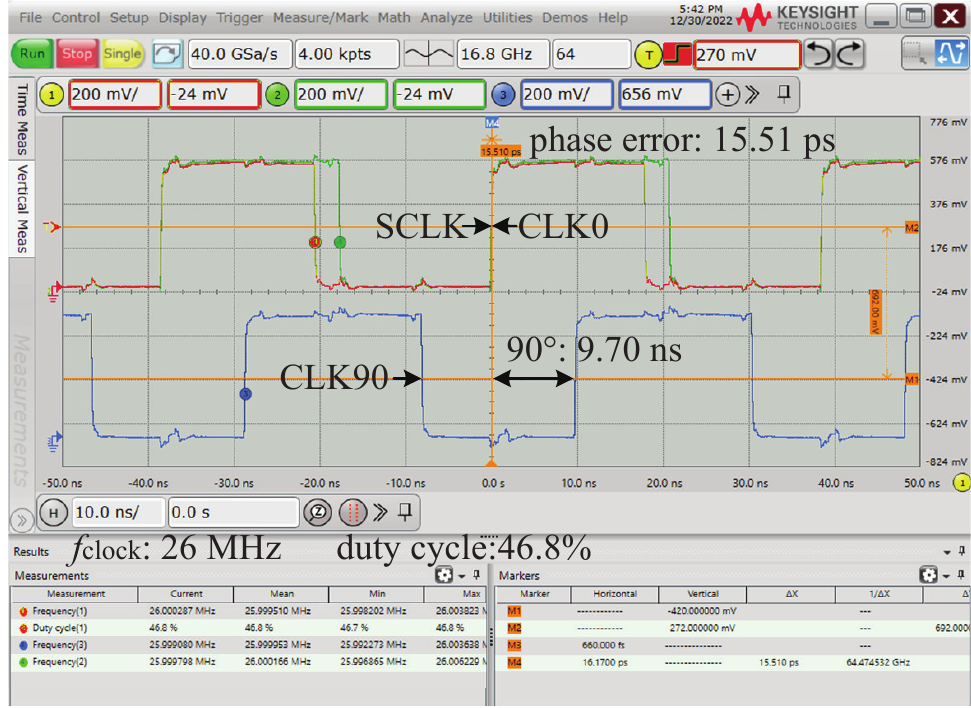
Figure 17. The chip testing results of proposed four-phase DLL with de-skew circuit at f clock = 26 MHz.